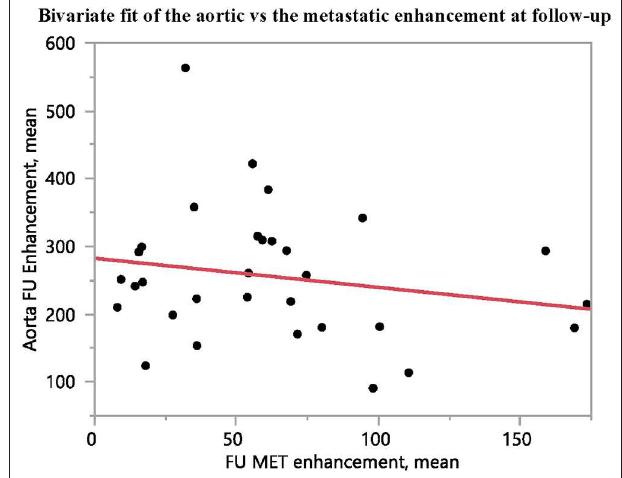
FIGURE 4 | The contrast-enhancement in the abdominal aorta at the level of the coeliac trunk shows no correlation to the contrast-enhancement of the metastases at follow-up ( n = 31, R 2 = 0.04, p =